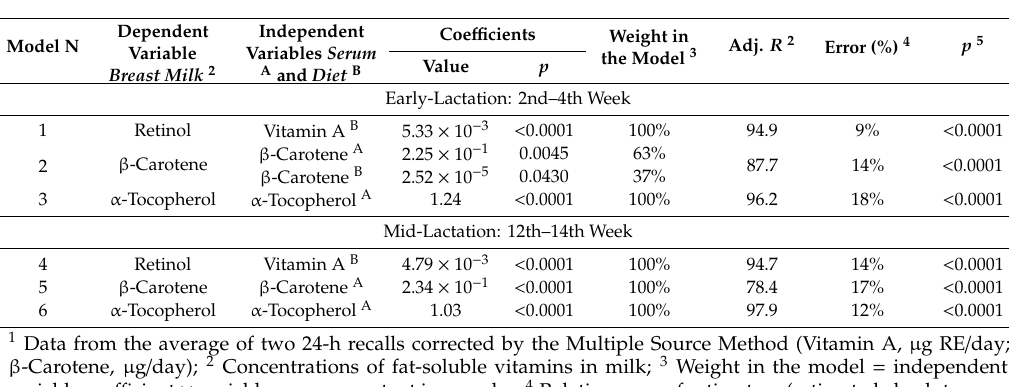
Table 4. Multiple regression models of the concentrations of vitamin A and E ( µ mol / L) in the milk of Brazilian nursing women ( n = 19), to assess its associations with the intake 1 and serum contents of these